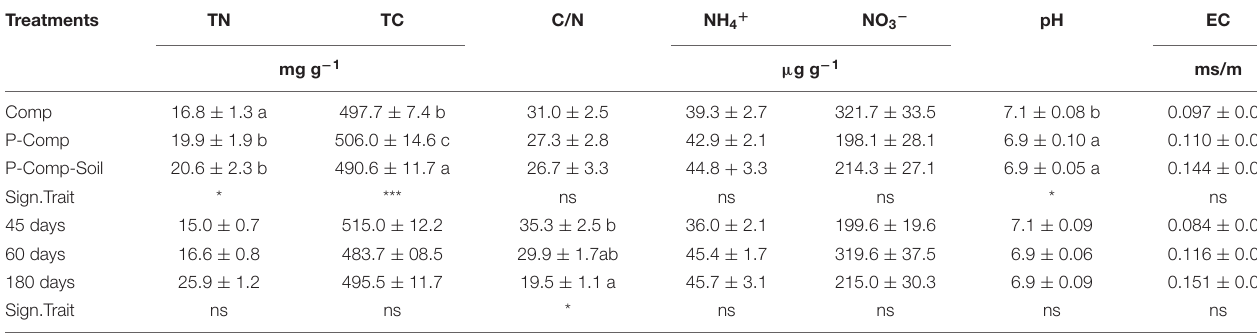
TABLE 3 | Combined data of non-P chemical properties following a two-way ANOVA.